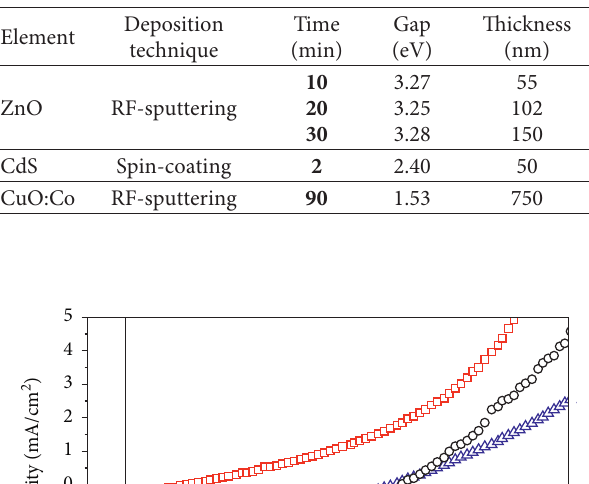
Figure 1: Transmission spectra of the ZnO, CdS, and CuO:Co thin films as a function of the wavelength. The inset shows the band diagrams of the isolated states of the ITO/ZnO/CdS/CuO:Co/Ag heterojunction under the equilibrium condition. Table 1: Optical properties and preparation conditions of the ZnO, CdS, and CuO:Co thin films.